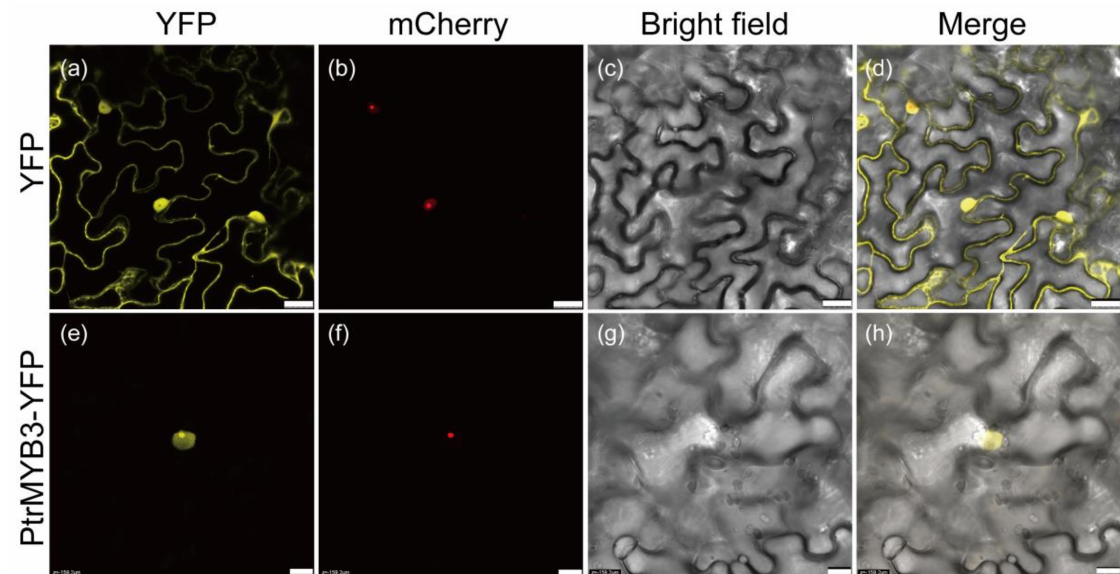
Figure 3. Subcellular localization of PtrMYB3. The representative images indicate cells expressing YFP ( a – d ) or PtrMYB3- YFP fusion protein ( e – h ) under different fields, including yellow fluorescence (YFP, ( a , e )), red fluorescence (mCherry, ( b , f )), bright field ( c , g ) and merged field ( d , h ). The red fluorescence images ( b , f ) show the signal of a nuclear marker gene VirD2NLS fused to mCherry. Bar, shown at the right bottom, =25 µ m (upper panels) and 10 µ m (bottom panels).